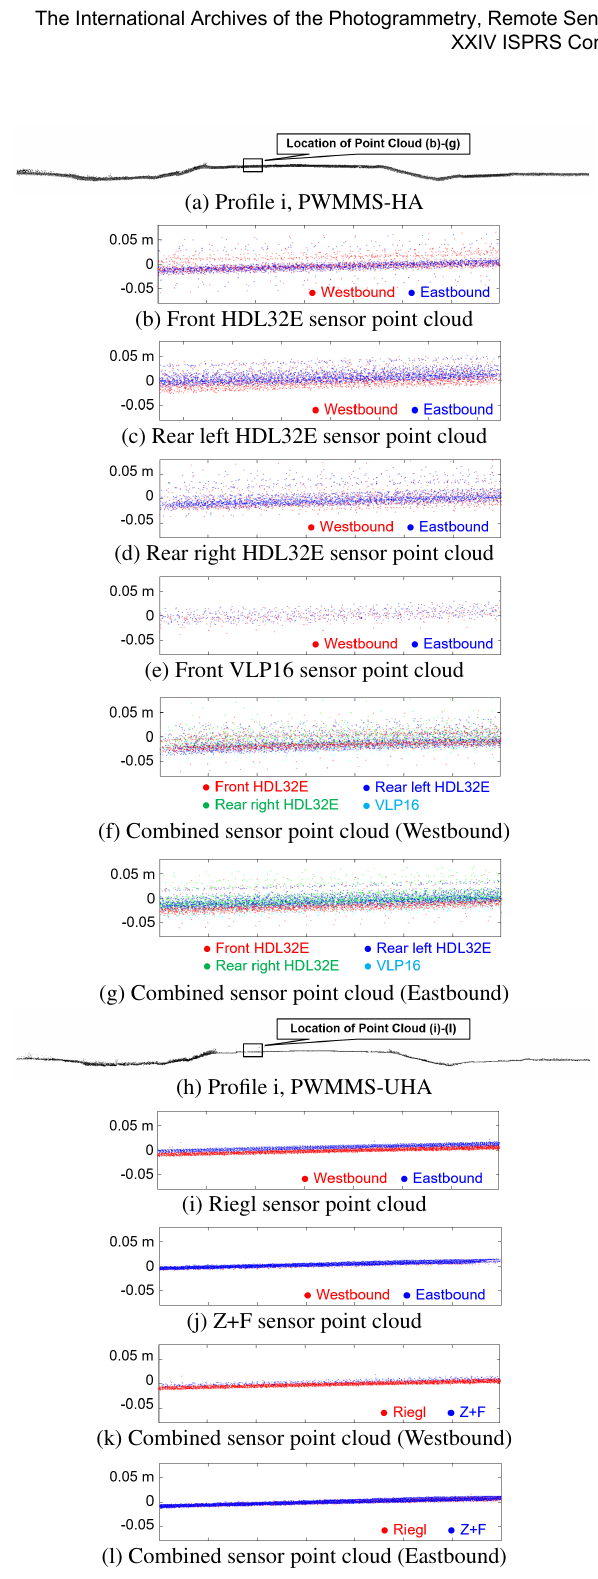
Figure 3: Point cloud compatibility between different sensors and tracks (using profile i as an example). The units of the horizontal and vertical axes are in meters with one-meter separation between the ticks along the horizontal